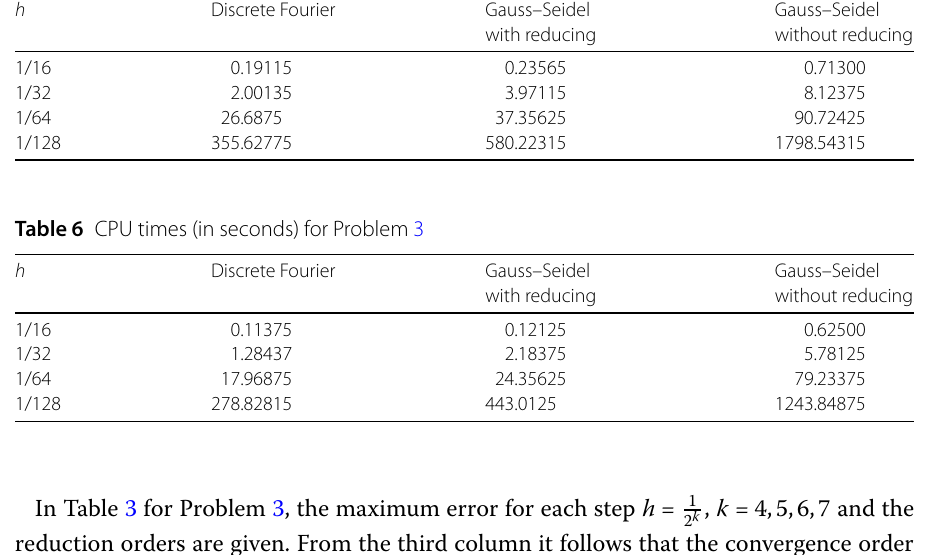
Table 5 CPU times (in seconds) for Problem 2 h